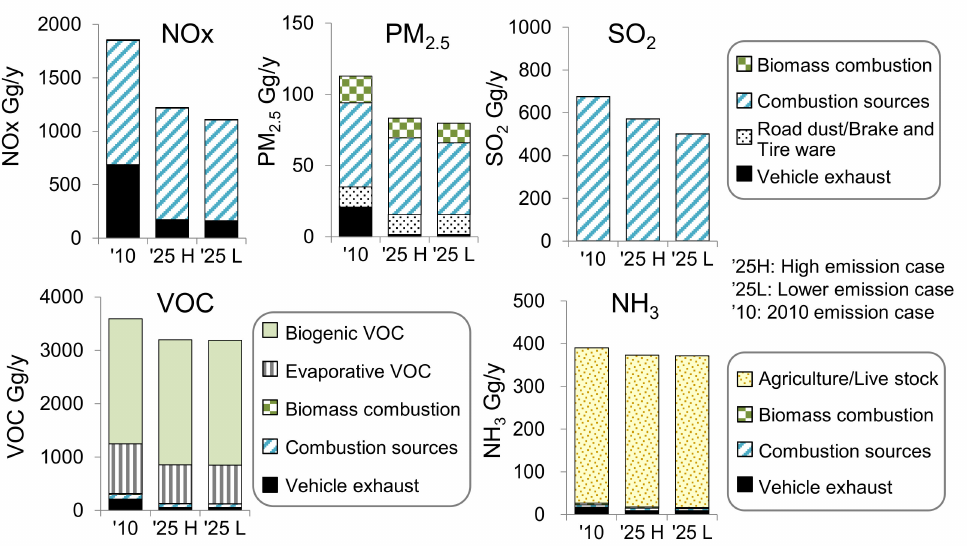
Figure 13. Future emission inventory for the 2025 fiscal year.